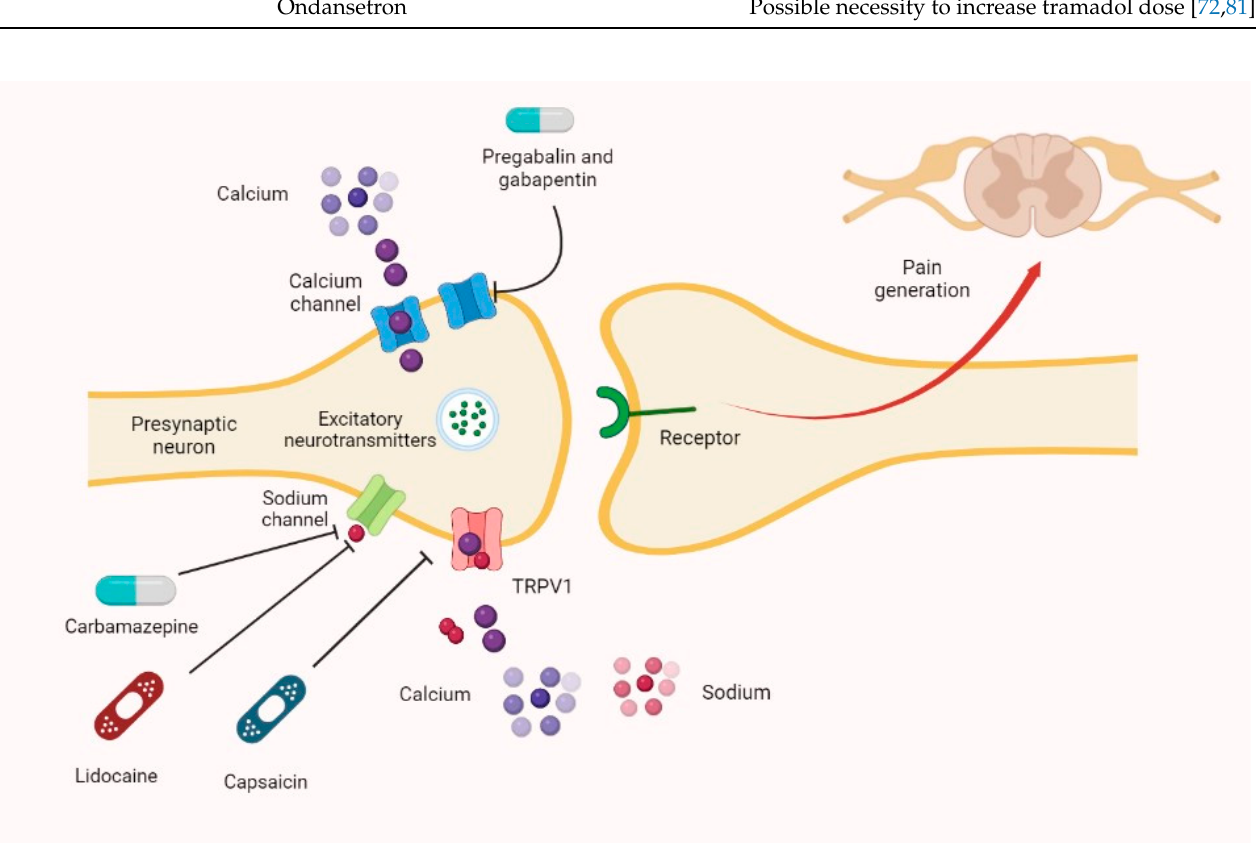
Figure 3. Other neuropathic pain drugs’ mechanisms of action. The main principle of counteracting neuropathic pain is reducing the release of excitatory neurotransmitters in the synaptic cleft. Car- bamazepine and lidocaine inhibit sodium channels, whereas capsaicin exerts its activity on TRPV1. Pregabalin and gabapentin block calcium channels in their α 2 δ subunit. TRPV1—transient receptor potential cation channel subfamily V member 1.